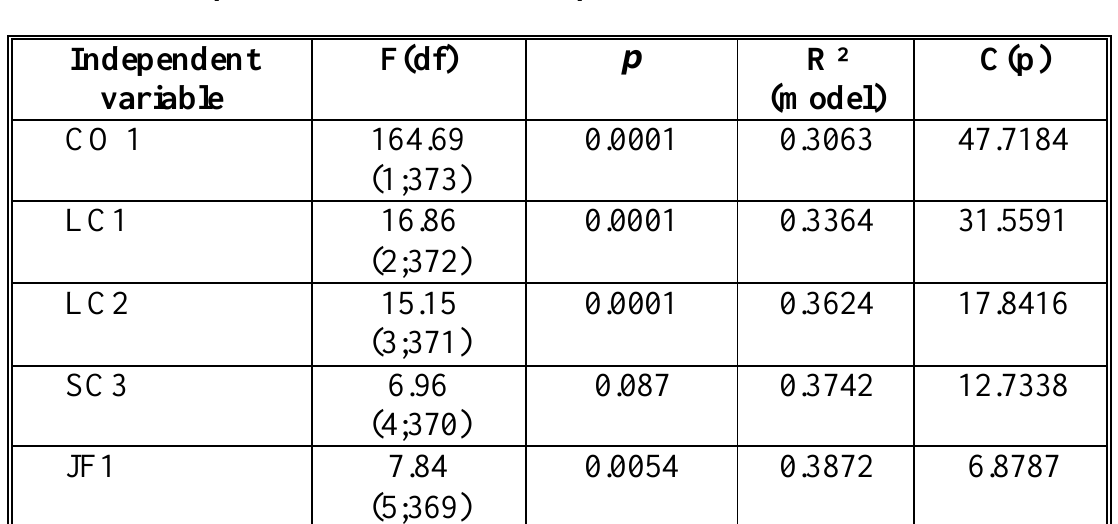
Dependent variable: Entrepreneurial attitude total (N = 375)